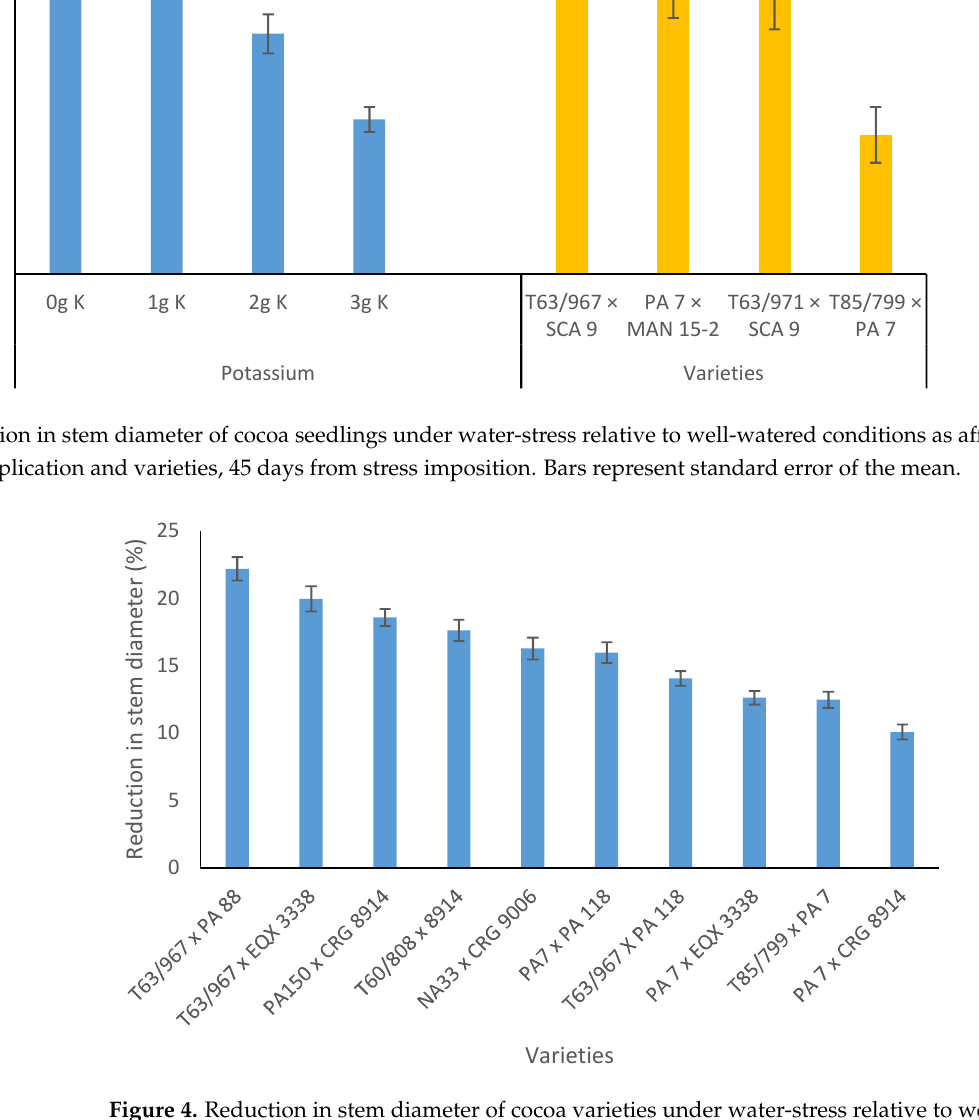
Figure 4. Reduction in stem diameter of cocoa varieties under water-stress relative to well-watered conditions 40 days from stress imposition. Bars represent standard error of the mean.